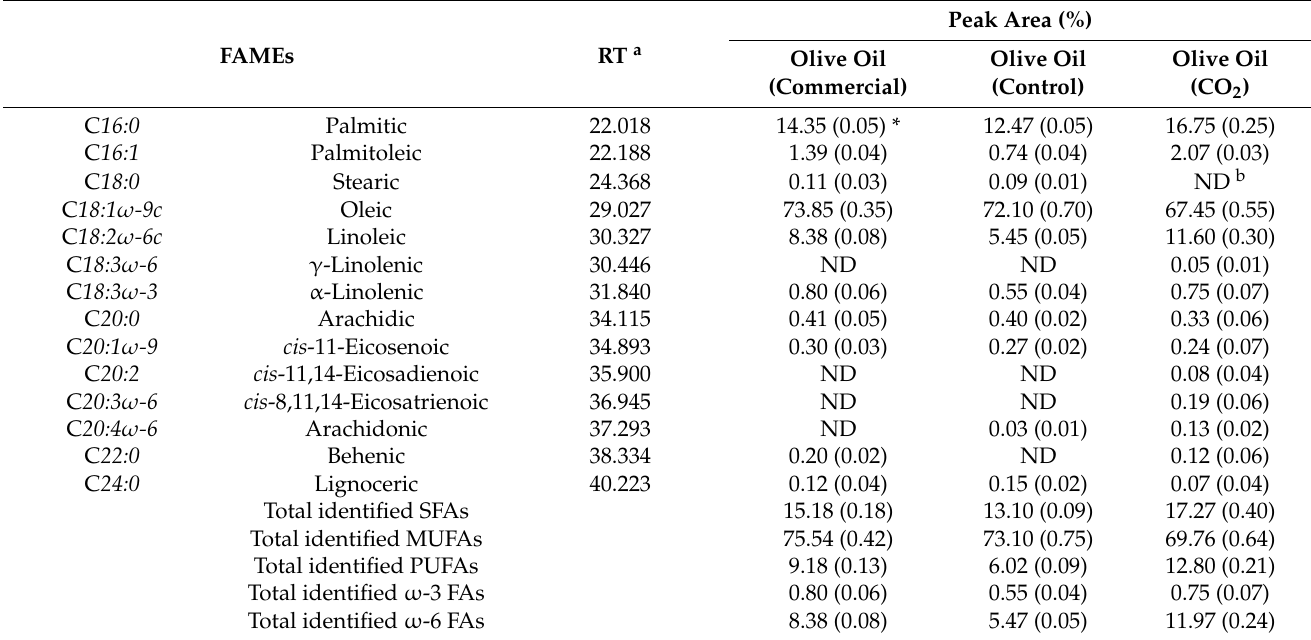
Table 4. Fatty acid composition of olive